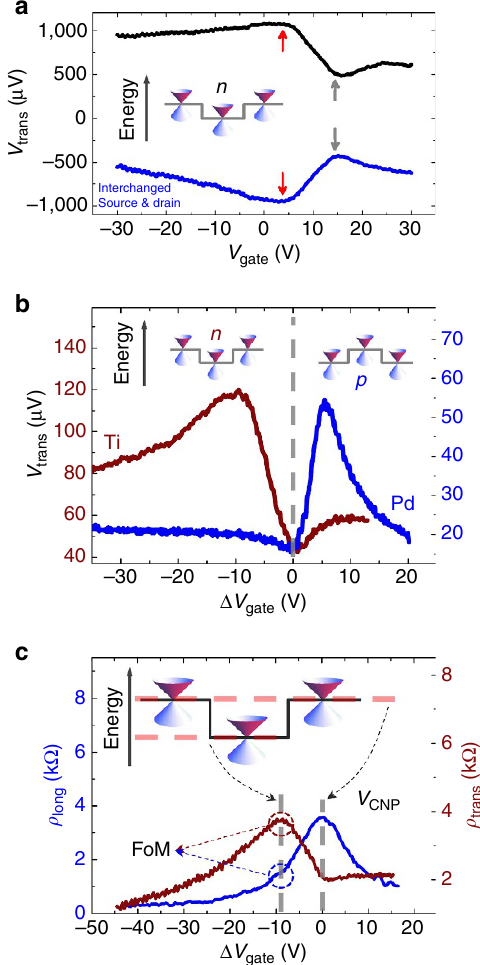
Figure 2 | Symmetry of the transverse-signal generated by cascaded Mie scattering at room temperature. ( a ) Transverse voltage V trans as function of gate-voltage V gate for a canted a 2D (cid:2) SL ¼ 30 (cid:2) 2D-SL sample (Ti dots). V trans shows two extreme points, a maximum (red arrow) at about 8 V and a minimum (black arrow) about 14V. As expected, on reversal of the current direction I b - (cid:2) I b (inverting source- and drain-electrodes), V trans reverses, too. ( b ) V trans for a Ti- (dark red) and Pd- (dark blue) defined canted 2D-SL sample. The transverse signals are plotted against D V gate , the gate-voltage relative to the charge-neutrality point. As expected from the energy dependence of Klein tunnelling which underlies Mie scattering, the minima of both signals are at the charge-neutrality point ( D V gate ¼ 0) and the maxima are found on opposite sides of D V gate . The opposite positioning of the maxima is a direct consequence of the inversion of the shift in local potential 13–15 ( cf . insets) by choosing either Ti ( n -type) or Pd ( p -type) as dot material. The maximum is reached when the gate-voltage (carrier-energy) is at the maximum of the local potential shift. ( c ) longitudinal and transverse resistivity, r long (blue) and r trans (dark red), respectively, against D V gate for a canted ( a 2D (cid:2) SL ¼ 30 (cid:2) ) Ti-dots 2D-SL sample. r long shows the usual ambipolar dependence with a maximum at the charge-neutrality point V CNP as was observed in all samples with, both, canted and aligned geometry. That is, our 2D-SLs do not affect graphene’s bandstructure 12 . P trans has the identical characteristics as its corresponding transverse voltage, as observed in all samples investigated. Dashed circles indicate the relevant values for determining the